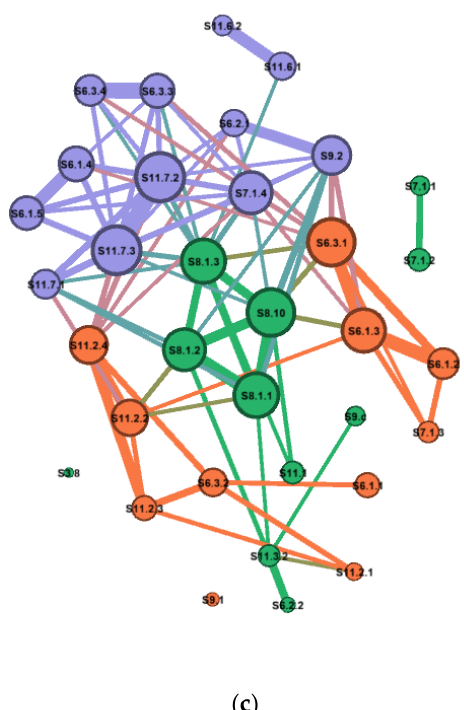
Figure A1. The correlation network among the indicators with different proportions of links. ( a ) All links included, ( b ) Only the links with the higher 50% of weights are included, ( c ) Only the links with the highest 25% of weights are included.